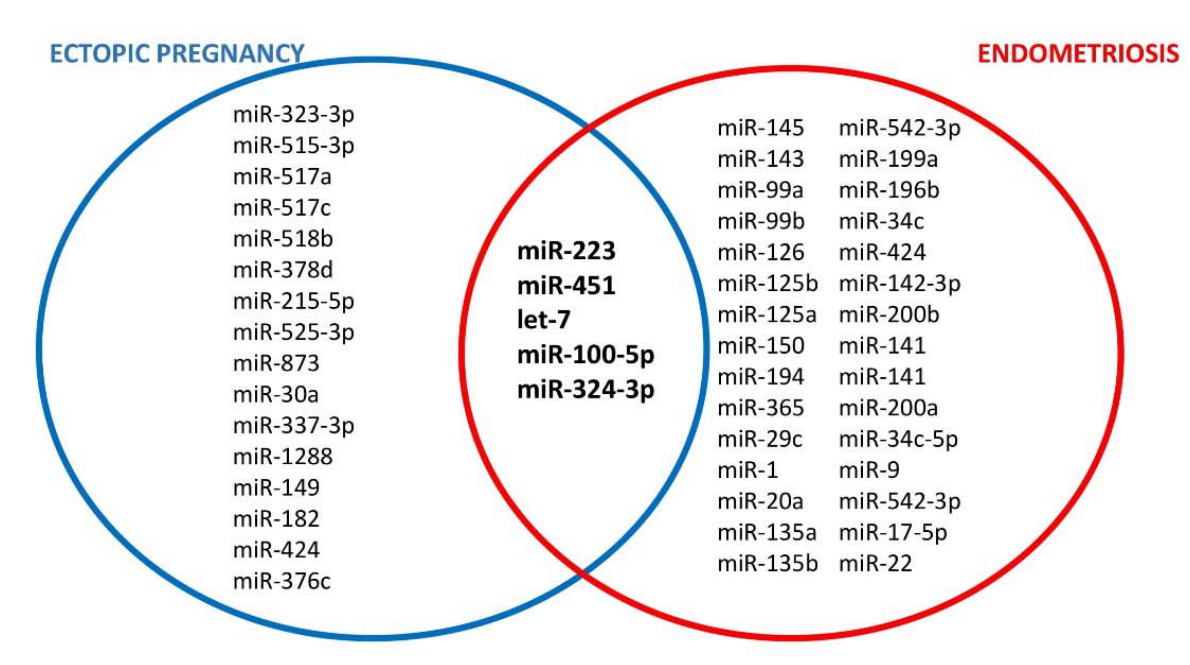
Figure 3. The most common miRNAs involved in the pathophysiology of EP and endometriosis. Dominguez et al. investigated the miRNA profile of embryonic tissues in ectopic pregnancies and controlled voluntary abortions. They found four miRNAs that were downregulated and three miRNAs that were upregulated in EP. Among the upregulated